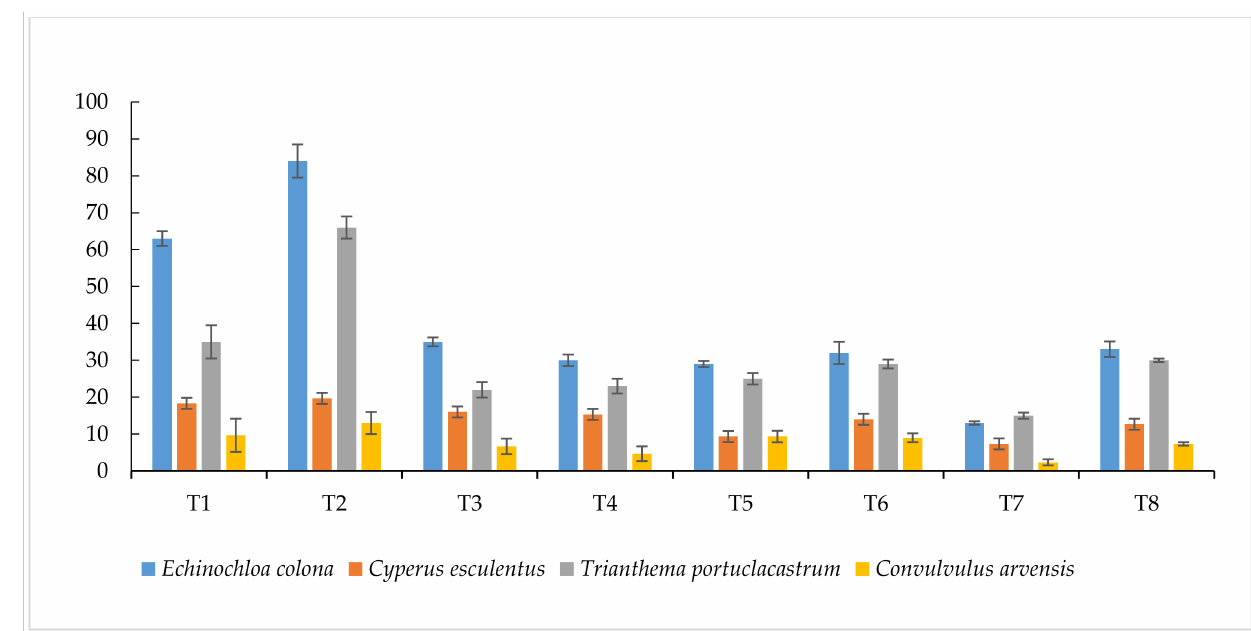
Figure 2. Density (m − 2 ) of different weed species in sole and maize-gram intercropping systems at final harvest. (T 1 = sole maize in 60 cm distanced single rows, T 2 = sole maize in 90 cm distanced double row strips, T 3 = sole black gram in 30 cm distanced single rows, T 4 = sole green gram in 30 cm distanced single rows, T 5 = six single rows (60 cm apart) of maize with twelve double rows (20 cm) of black gram, T 6 = six single rows (60 cm apart) of maize with twelve double rows (20 cm) of green gram, T 7 = three double rows (90 cm apart) of maize with three sets of quadratic rows (20 cm apart) of black gram, T 8 = three double rows (90 cm apart) of maize with three sets of quadratic rows (20 cm apart) of green gram). Table 2. 1000 grains weight (GW), grain yield (GY), biological yield (BY) and harvest index (HI) of sole maize and in intercropping systems with green gram and black gram under semi-arid conditions.